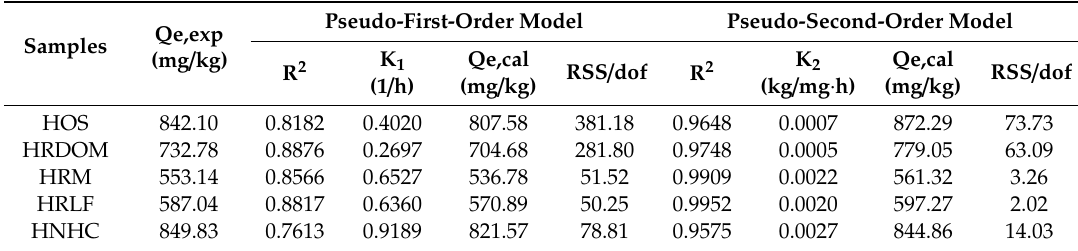
Table 3. The adsorption kinetics model fitted parameters.